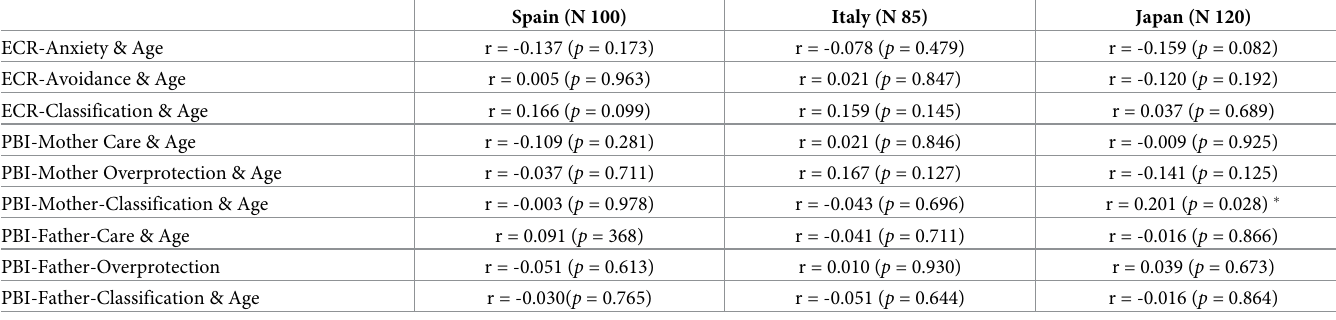
Table 5. Spearman’s r correlations between age, ECR and PBI